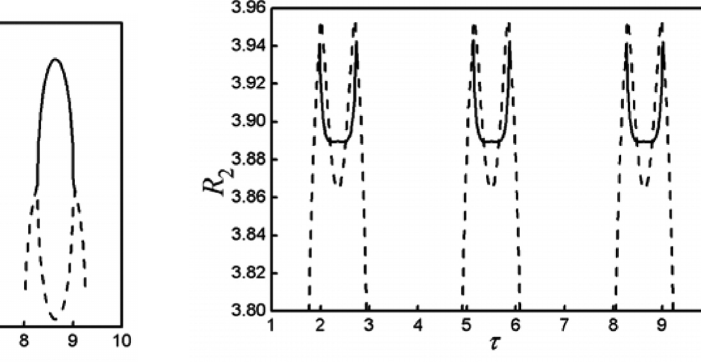
Fig. 7. Variation of R 1 with τ . Fig. 8. Variation of R 2 with τ .